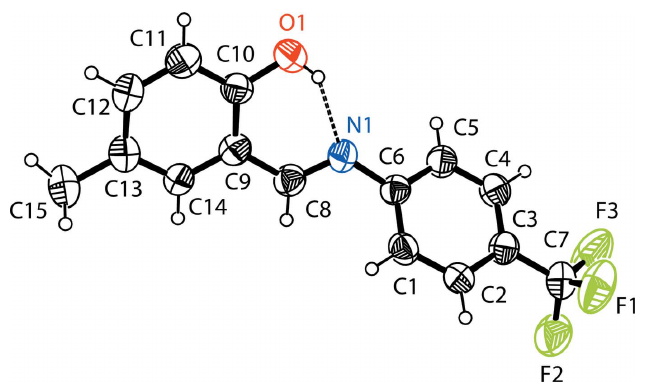
Figure 1 The molecular structure of (I) with the atom-numbering scheme. Displacement ellipsoids are drawn at the 40% probability level. The intramolecular O—H (cid:2)(cid:2)(cid:2) N hydrogen bond (Table 1) is shown as a dashed line.